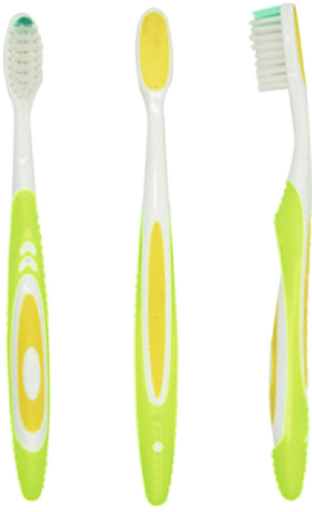
Figure 1: Conventional